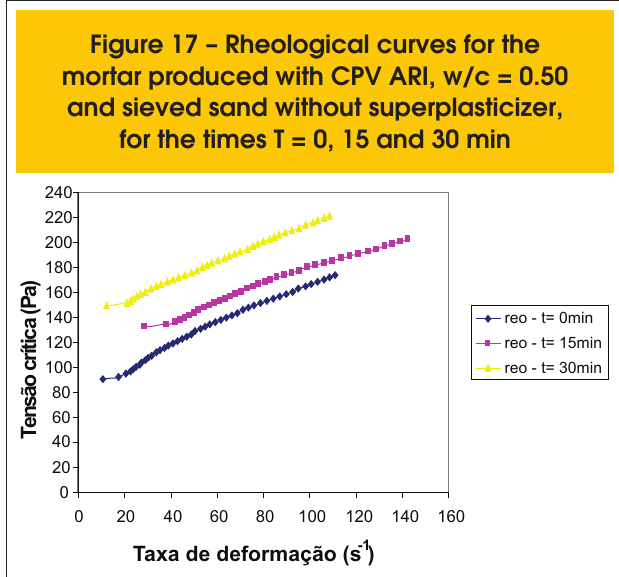
Figure 17 – Rheological curves for the mortar produced with CPV ARI, w/c = 0.50 and sieved sand without superplasticizer, for the times T = 0, 15 and 30 min